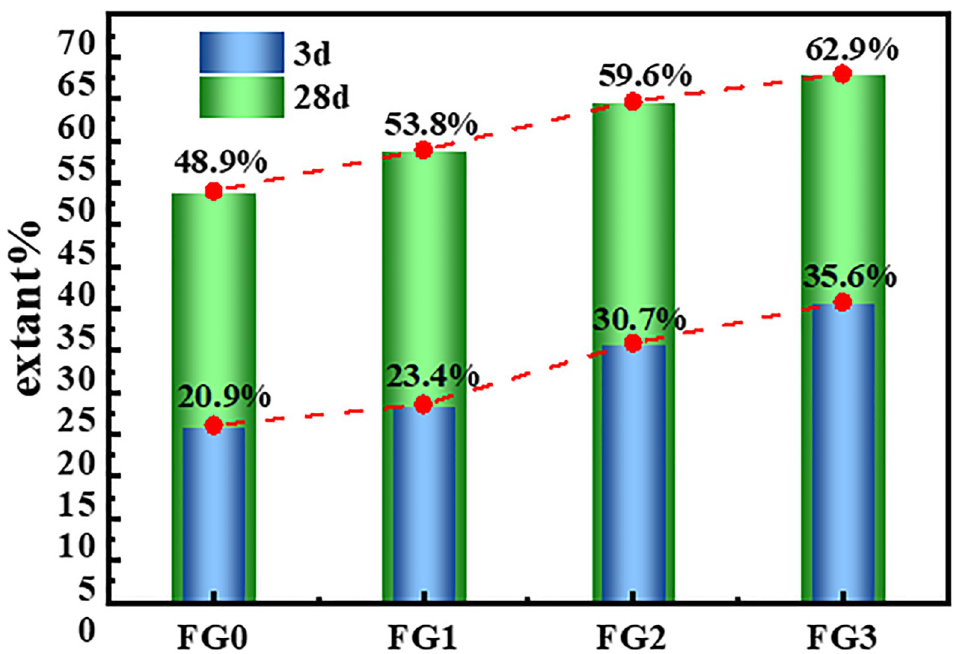
Fig 18. Effect of different grinding degrees of fly ash on the degree of geopolymer reaction.